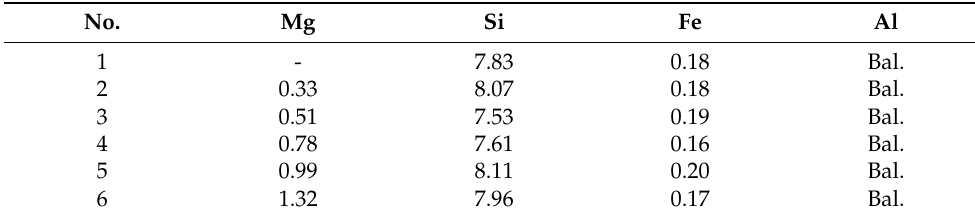
Table 1. Compositions of the alloy ingots in the present study (mass %). No. Mg Si Fe Al 1